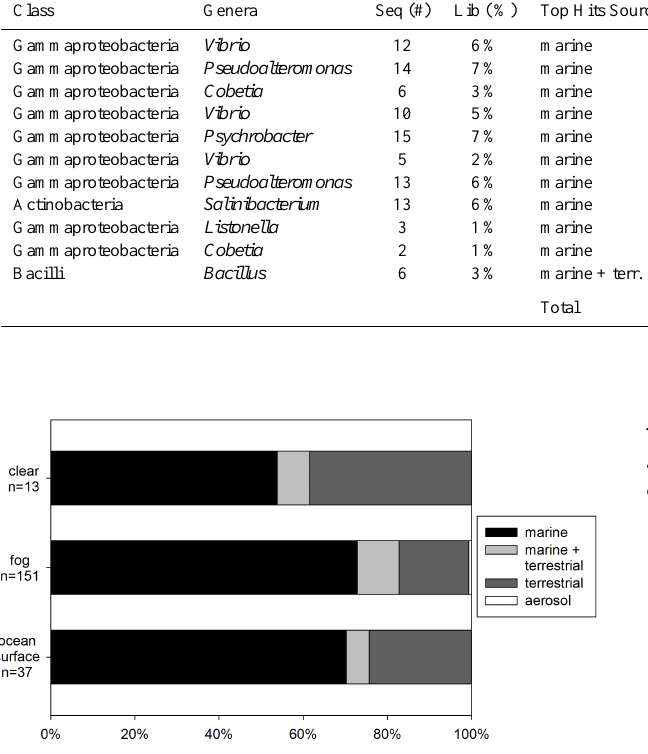
Fig. 5. Top hits source analysis for clear, fog, and ocean sequence libraries (coastal Maine, USA).